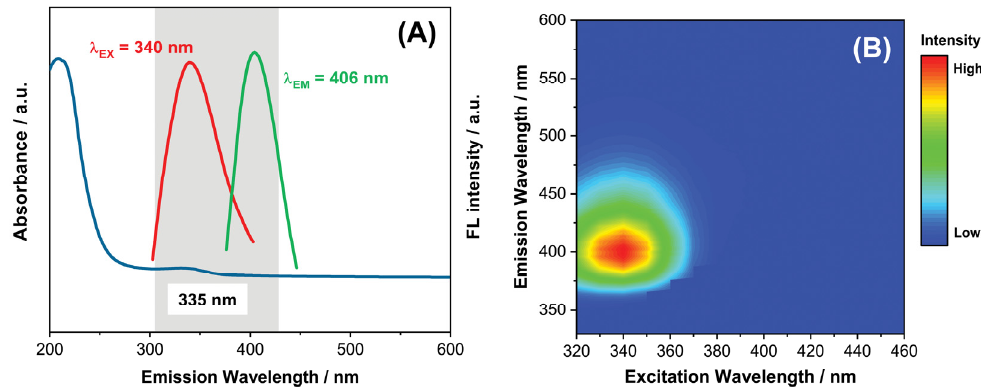
Figure 10. ( A ) UV–Vis absorption spectrum with maximum fluorescence excitation and emission spectrum, and ( B ) 2D excitation–emission contour map of CQD@Leu